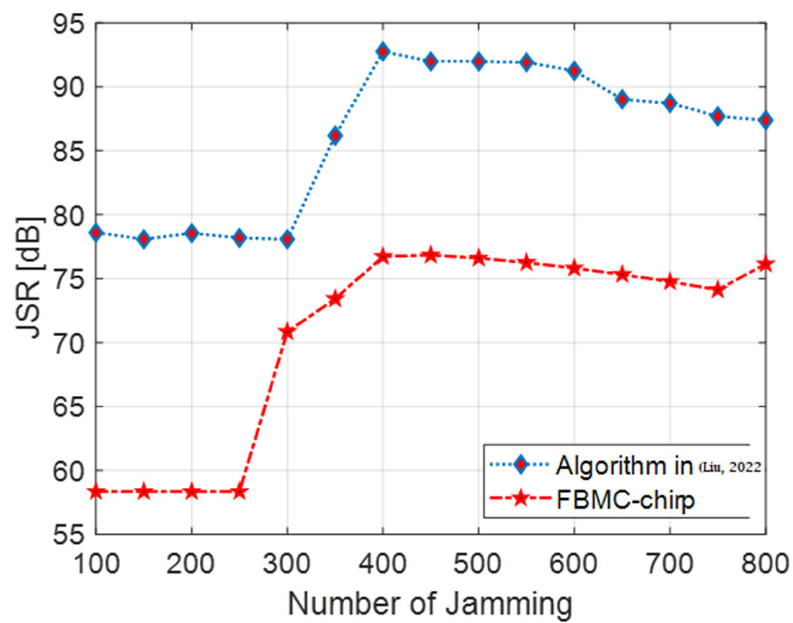
Figure 16. Trade ‐ off between the jamming signal ratio and the number of false targets; SNR = 12 dB [24].